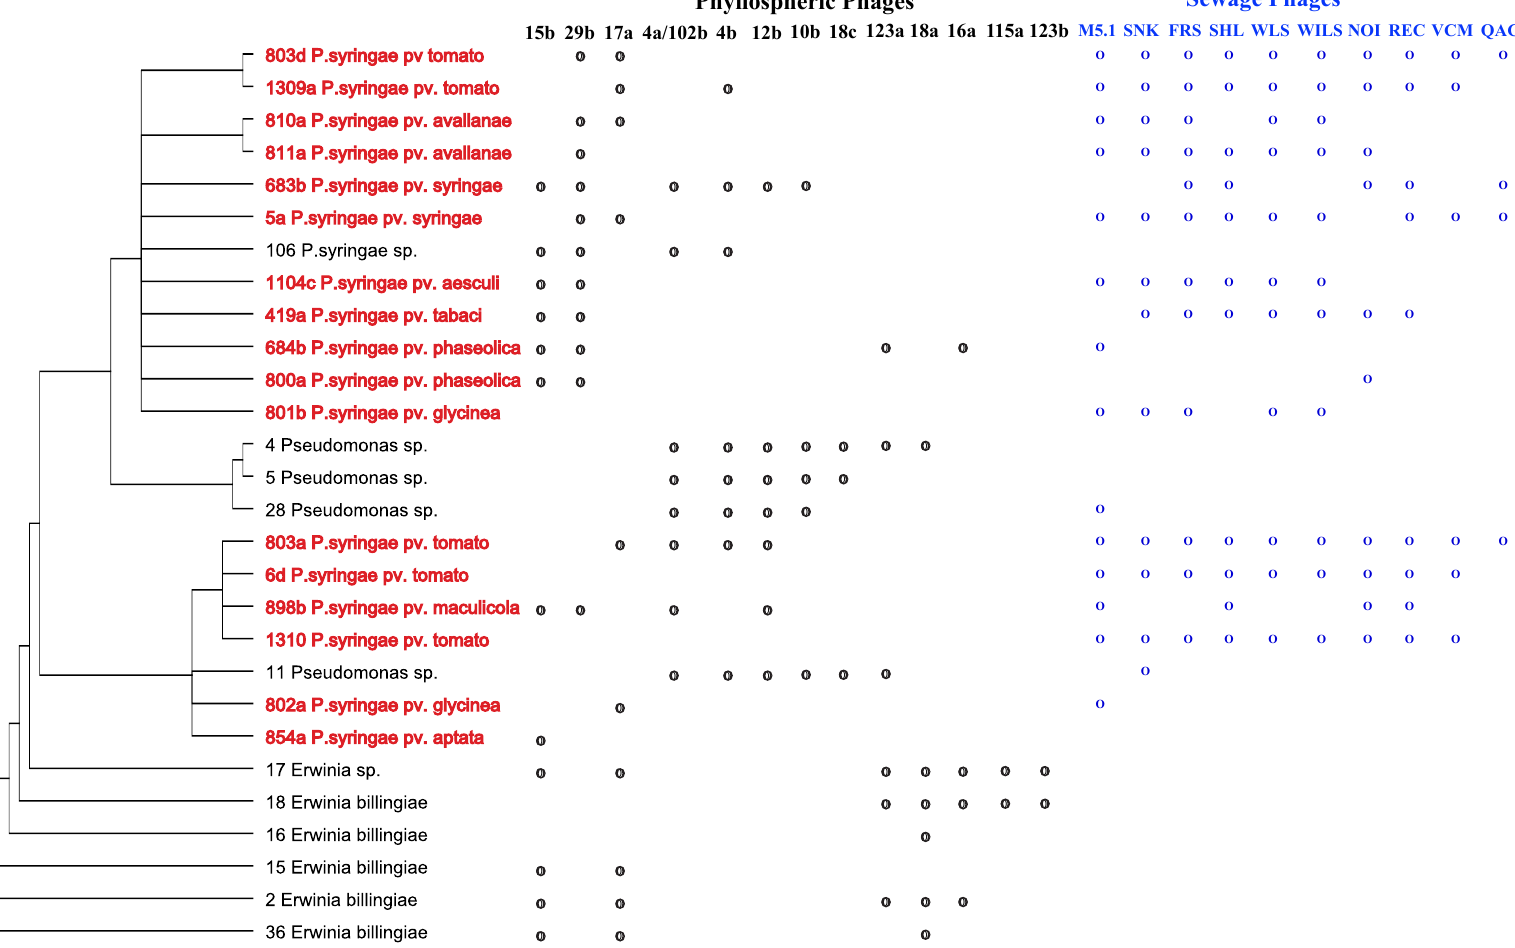
Figure 2. Neighbor-joining tree showing the phylogenetic relationships among bacteria used in this study and their susceptibility to bacteriophages from the phyllosphere (black) or from sewage (blue). Trees are based on 16S rRNA gene sequences ( ∼ 800 bp). Bacterial isolates in red have been classified previously to the pathovar level. Phages 4a and 102b had identical host ranges, despite being isolated from separate leaves, and their profiles have thus been collapsed into